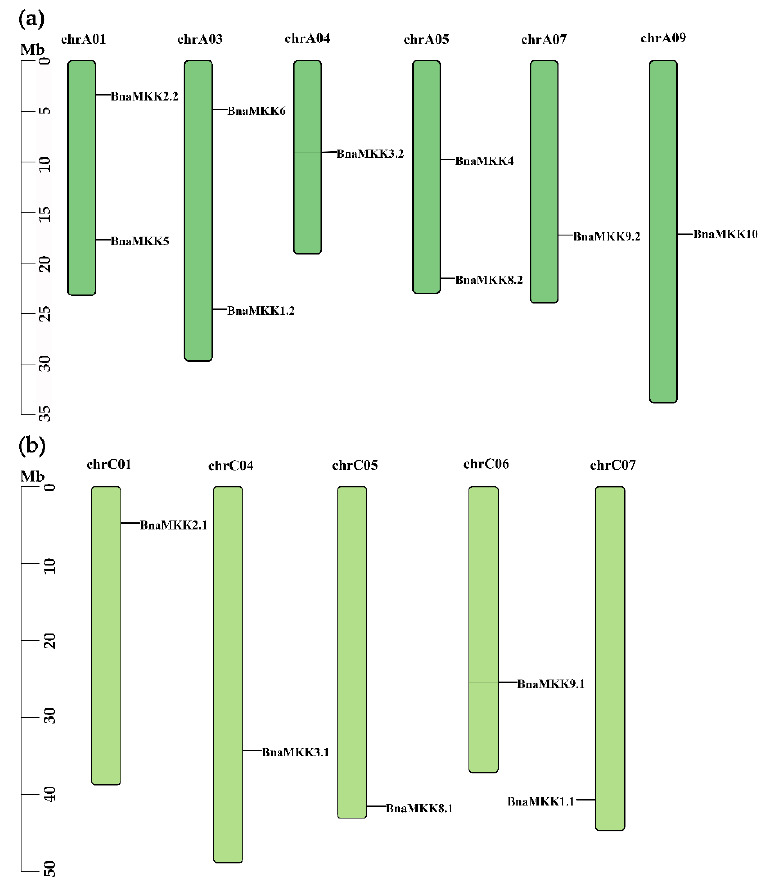
Figure 2. Chromosomal locations of BnaMKK genes in B. napus genome. ( a ) Genomic position of BnaMKK genes in subgenome A. ( b ) Genomic position of BnaMKK genes in subgenome C.